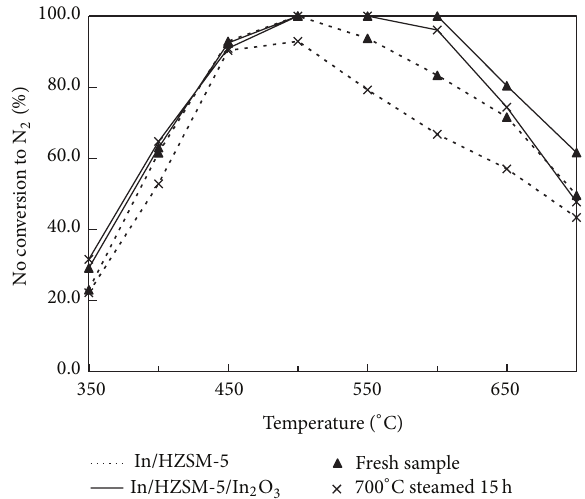
Figure 2: Effect of being pretreated with steam at high temperature for the activity of In/HZSM-5 and In/HZSM-5/In 2 O 3 . The sample was steamed with 4.0% H 2 O in He at 48 mL ⋅ min for 15 h prior to SCR run. Feed gas: 0.25% NO, 0.2% CH 4 , 2.0% O 2, and the balance of He; GHSV = 3600 h −1